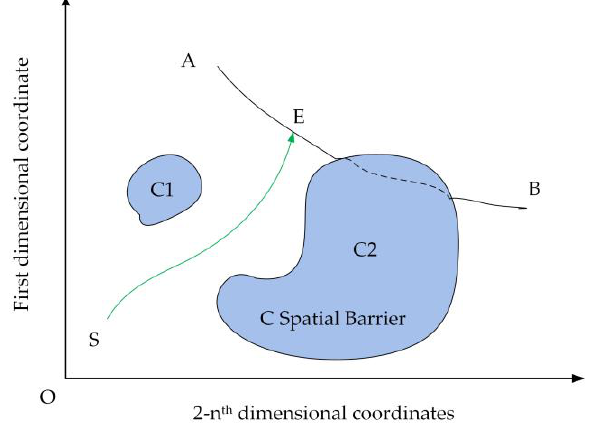
Figure 6. Robot arm C-spatial trajectory planning schematic.